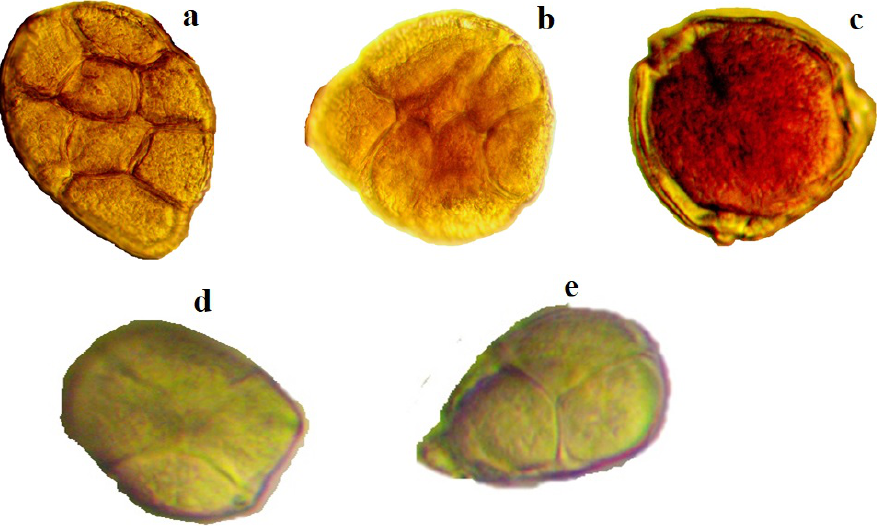
Figure 5. Light micrographs of pollen. Calliandra haematocephala ( a , b ), showing ( a ) equatorial view and ( b ) polar view. Entada phaseoloides, ( c ) showing polar view. Mimosa diplotricha. ( d ) showing tetrad-type pollen. Mimosa pudica ( e ), showing triyad-type pollen. Scale bar = 50 µm.